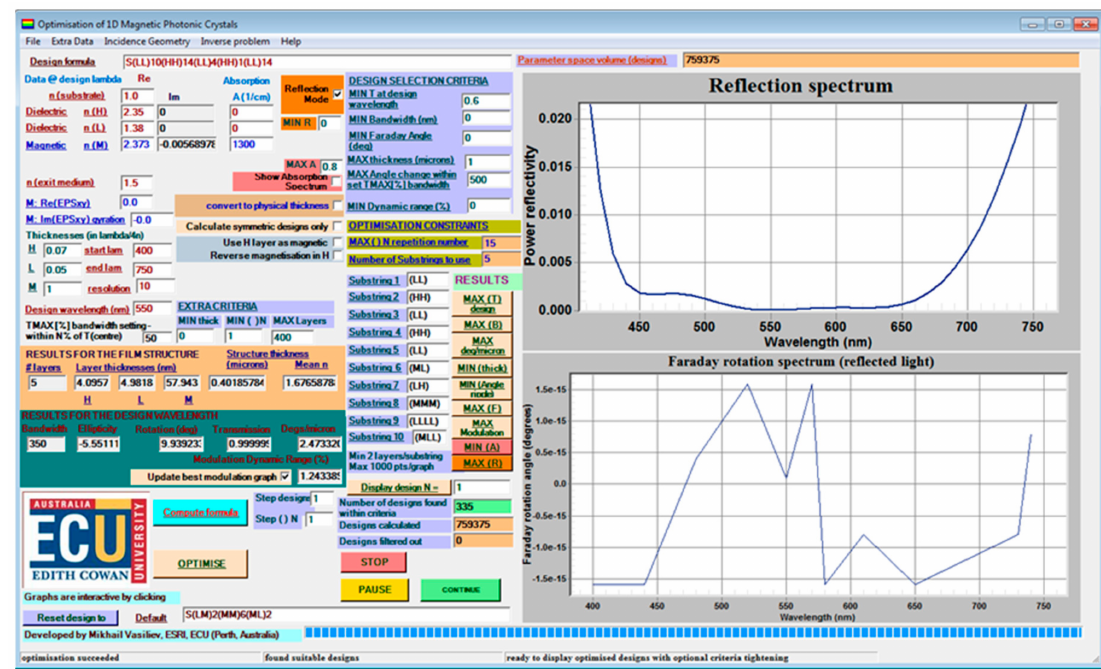
Figure 6. Example of menu and algorithm settings required to generate a number of optimized five-layer antireflector film designs on a glass substrate. In this example, the optical materials (ZnS and MgF 2 ) are presumed to possess constant refractive indices and zero absorption across the entire visible